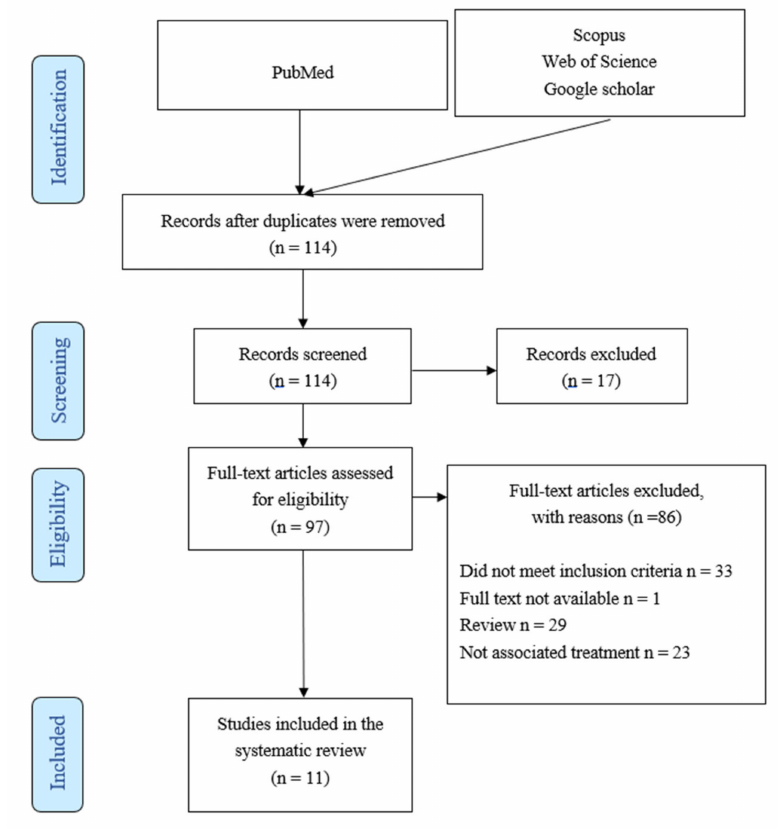
Figure 2. PRISMA Flow